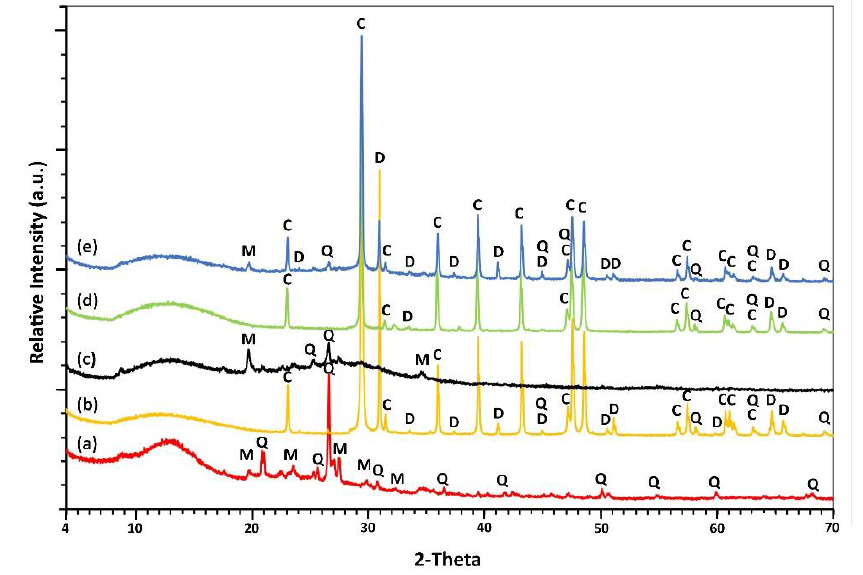
Figure 4. X-ray diffractograms of the raw materials ( a ) metakaolin, ( b ) marble waste, and the AAMs ( c ) MK, ( d ) MW, and ( e ) MW/MK 0.3, produced under the optimum conditions (H 2 O/Na 2 O molar ratio 16, curing temperature 40 °C). Identification of phases: C: Calcite (CaCO 3 ), D: Dolomite [CaMg(CO 3 ) 2 ], Q: Quartz (SiO 2 ) and M: Muscovite [KAl 2 (AlSi 3 O 10 )(OH) 2 ].